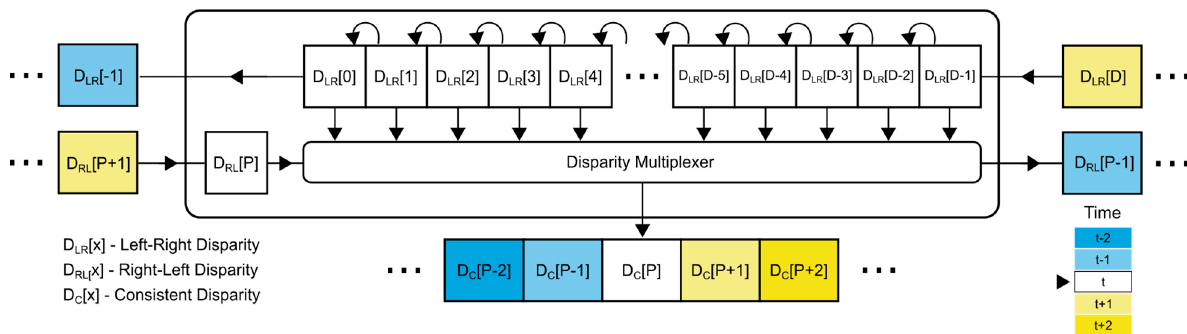
Figure 5. A high-level overview of the consistency checker design. The HLS pseudocode describing the above-presented behavior is displayed in Listing 3.